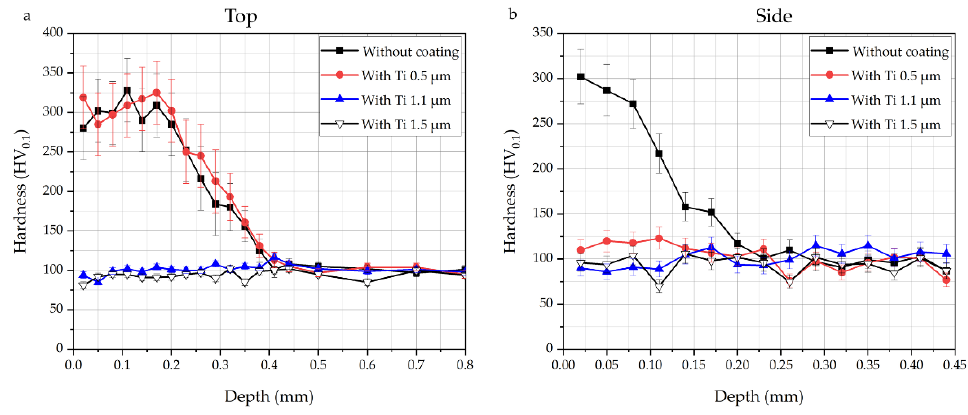
Figure 13. Microhardness profiles of ( a ) top of the samples and ( b ) side of the samples. The microhardness profiles confirm the OM observations. On the top (Figure 13a), the sample sintered using graphite foil without coating and the one sintered with a 0.5 µ m thick Ti coating present exactly the same hardness evolution: a high hardness of about 300 HV 0.1 from the surface to a depth of 200 µ m, corresponding to zones 1 and 2, followed by a decrease to 100 HV 0.1 at a depth of 400 µ m, corresponding to zone 3 and ending with a constant hardness of 100 HV 0.1, corresponding to zones 4 and 5, the pure iron. The samples sintered using graphite foils with 1.5 and 1.1 µ m thick Ti coatings present, from the surface to the bulk, the low hardness of 100 HV 0.1 ., confirming the absence of carburization. These values are in agreement with the one reported in the literature for pure ferrite (60